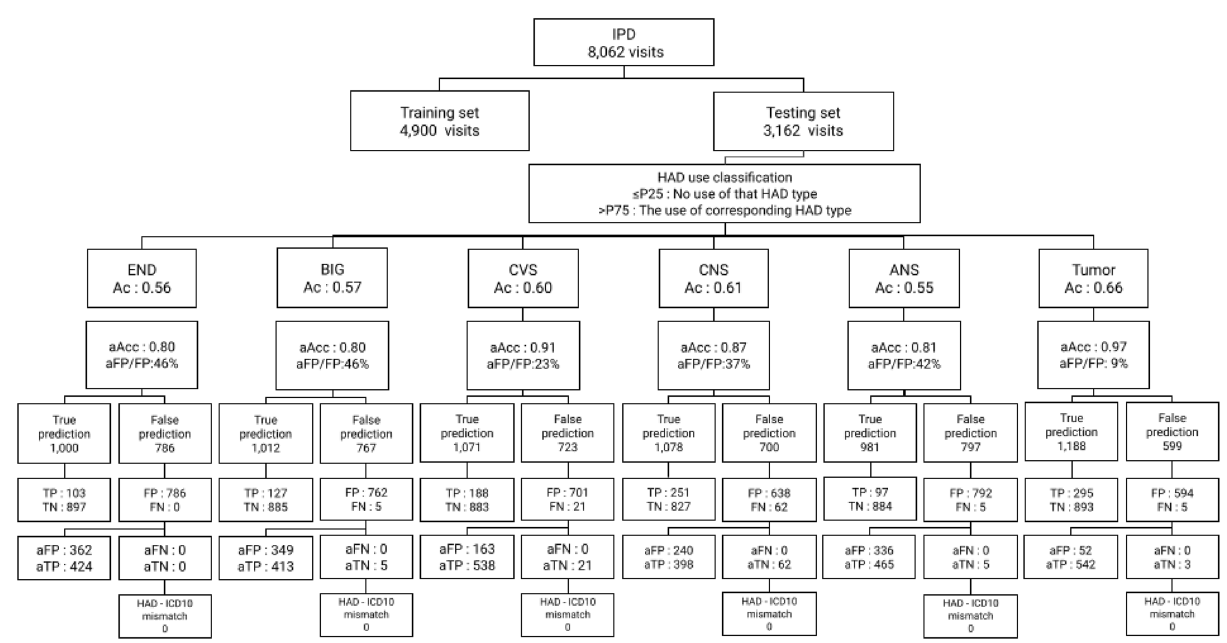
Figure 14. HAD–ICD10 mismatch in IPD data set in Cycle